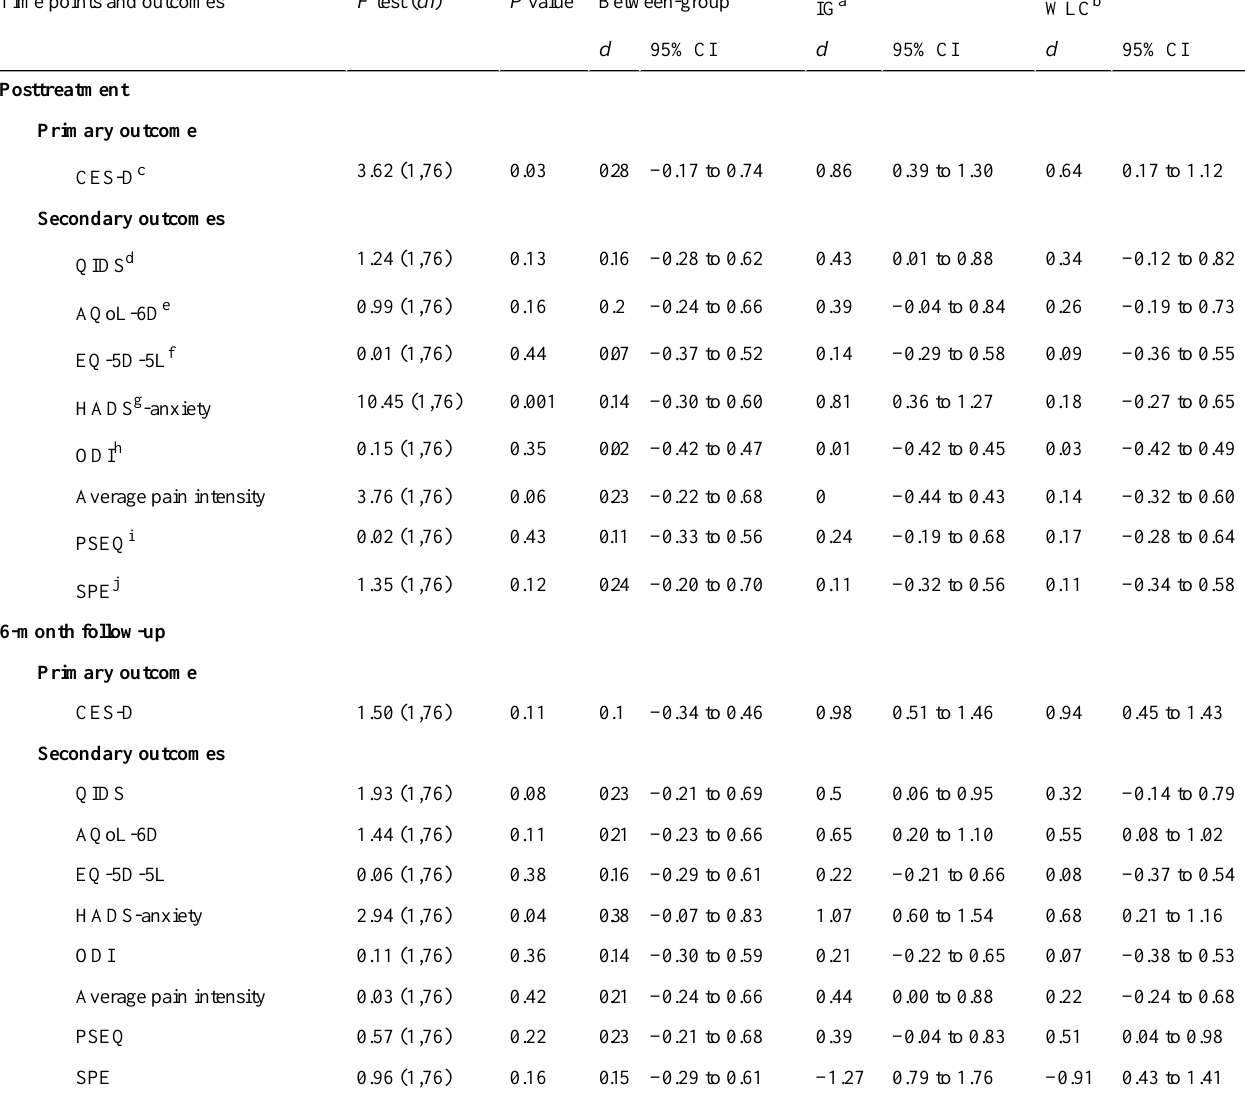
Table 5. Results of all